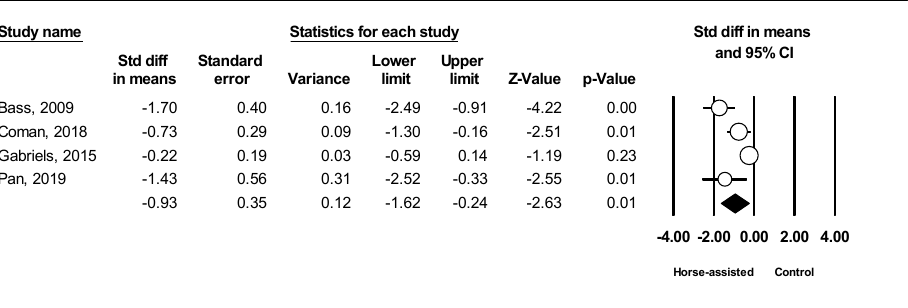
Figure 2. Forest plot showing the effects of horse-assisted therapy vs. control on social communica- tion [43,44,46].